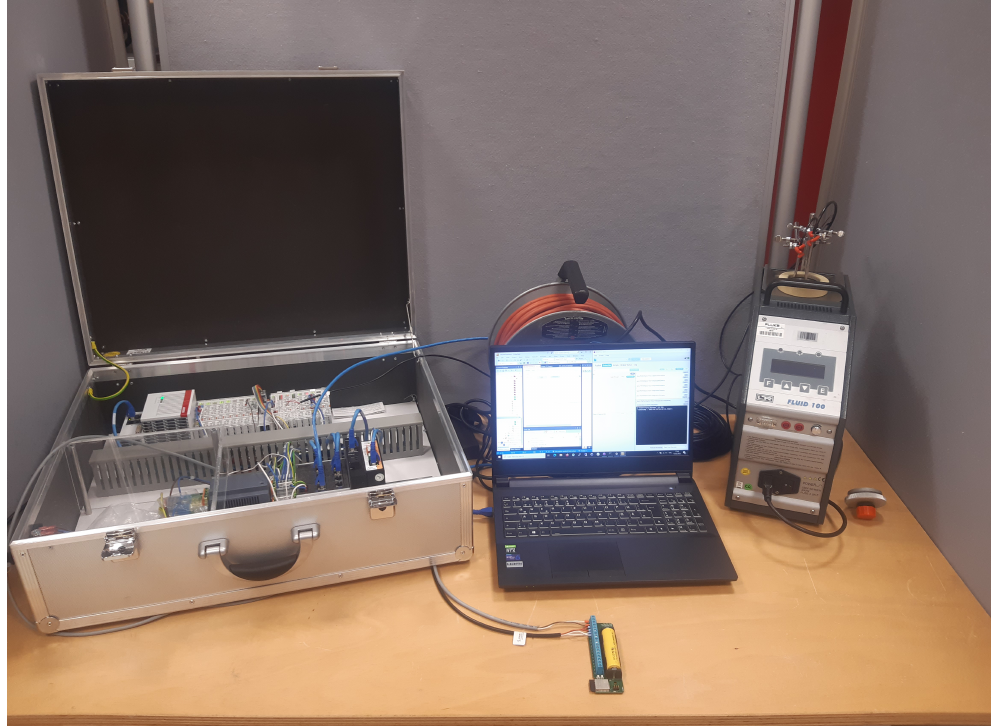
Figure 6. Experimental setup in real-world view. Left: PLC, center: notebook, front: TGW, right: temperature bath with temperature probes. The PLC is connected to the notebook via a direct Ethernet connection; the WiFi ™ router for the gateway (GW) communication is not displayed. The two visible connections of the TGW correspond to the connected Pt100 temperature probe and a 24VDC input signal to set the TGW up for internal processing instead of passing the signal (compare Section